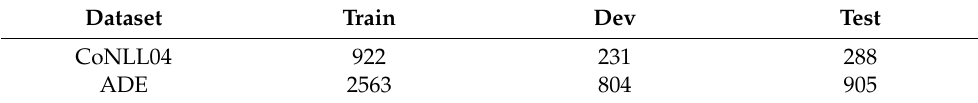
Table 1. The detal in some datasets. A series of experiments are carried out on them. Dataset Train Dev Test